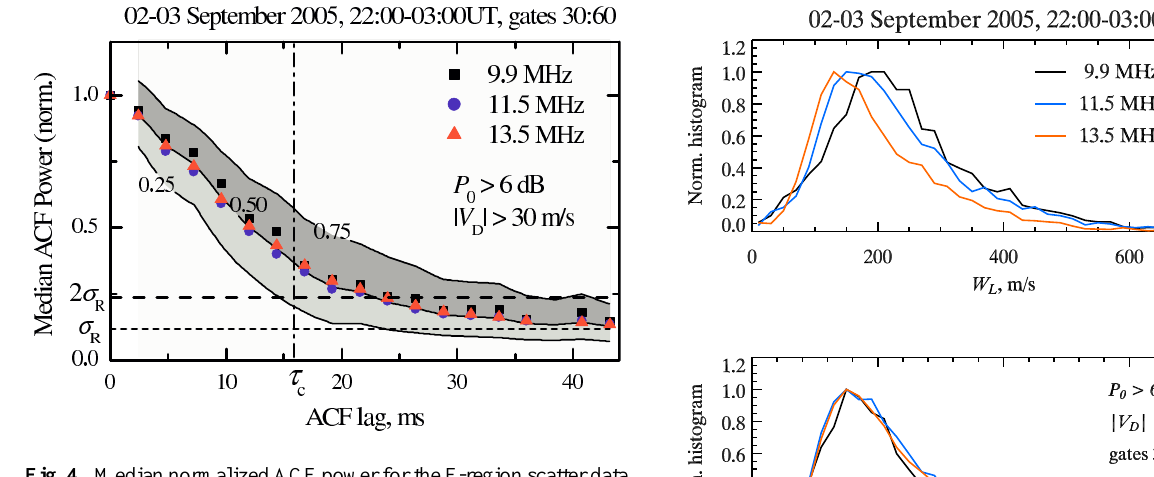
Fig. 4. Median normalized ACF power for the F-region scatter data identified by the red rectangle in Fig. 2 (squares, circles and trian- gles). All three frequencies exhibit very similar quasi-exponential shapes with e -fold decay time τ c ’ 16ms. Grey-scale contours cor- respond to first, second and third quartiles of the overall three-beam distribution at each ACF lag. Horizontal dotted line shows statis- tical fluctuation level, σ R = 1 / p N avg , where N avg = 78, the number of averaged pulse sequences used to obtain a single ACF. Further details on the significance of σ R are provided by Ponomarenko and Waters (2006).